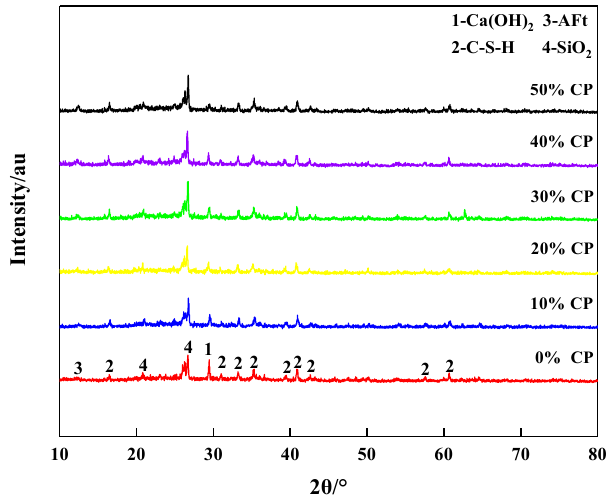
Figure 12. XRD patterns of CGFB samples.